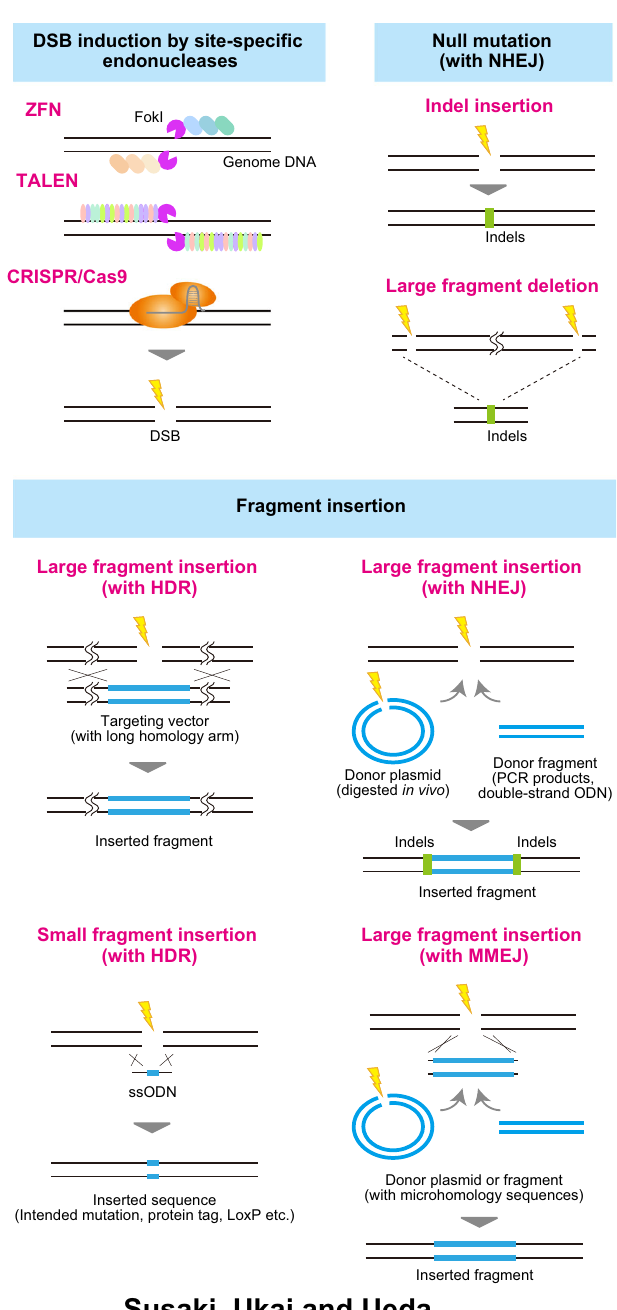
Fig. 2 DSB-mediated genome editing. Upper left : type of site-speci fi c endonucleases which are recently used for ef fi cient genome editing purposes. Upper right : introduction of a null mutation by DSB. When repaired by NHEJ pathway, small deletion or insertion of nucleotides (indels) occurred at the joint site, which cause a nonsense or missense mutation in the targeted ORF. Long deletions can also be introduced by multiple DSBs. Lower panels : strategies of fragment insertion. Homology-directed repair (HDR) supports insertion of a large or a small fragment with homology sequences. NHEJ also supports the insertion of a large fragment without homology sequence, although inserted direction is not controllable and indels are introduced at the joint regions. Microhomology-mediated end joining (MMEJ) mediates fragment insertion with very short (10 – 40 bp) microhomology arms and thus potentially ameliorates